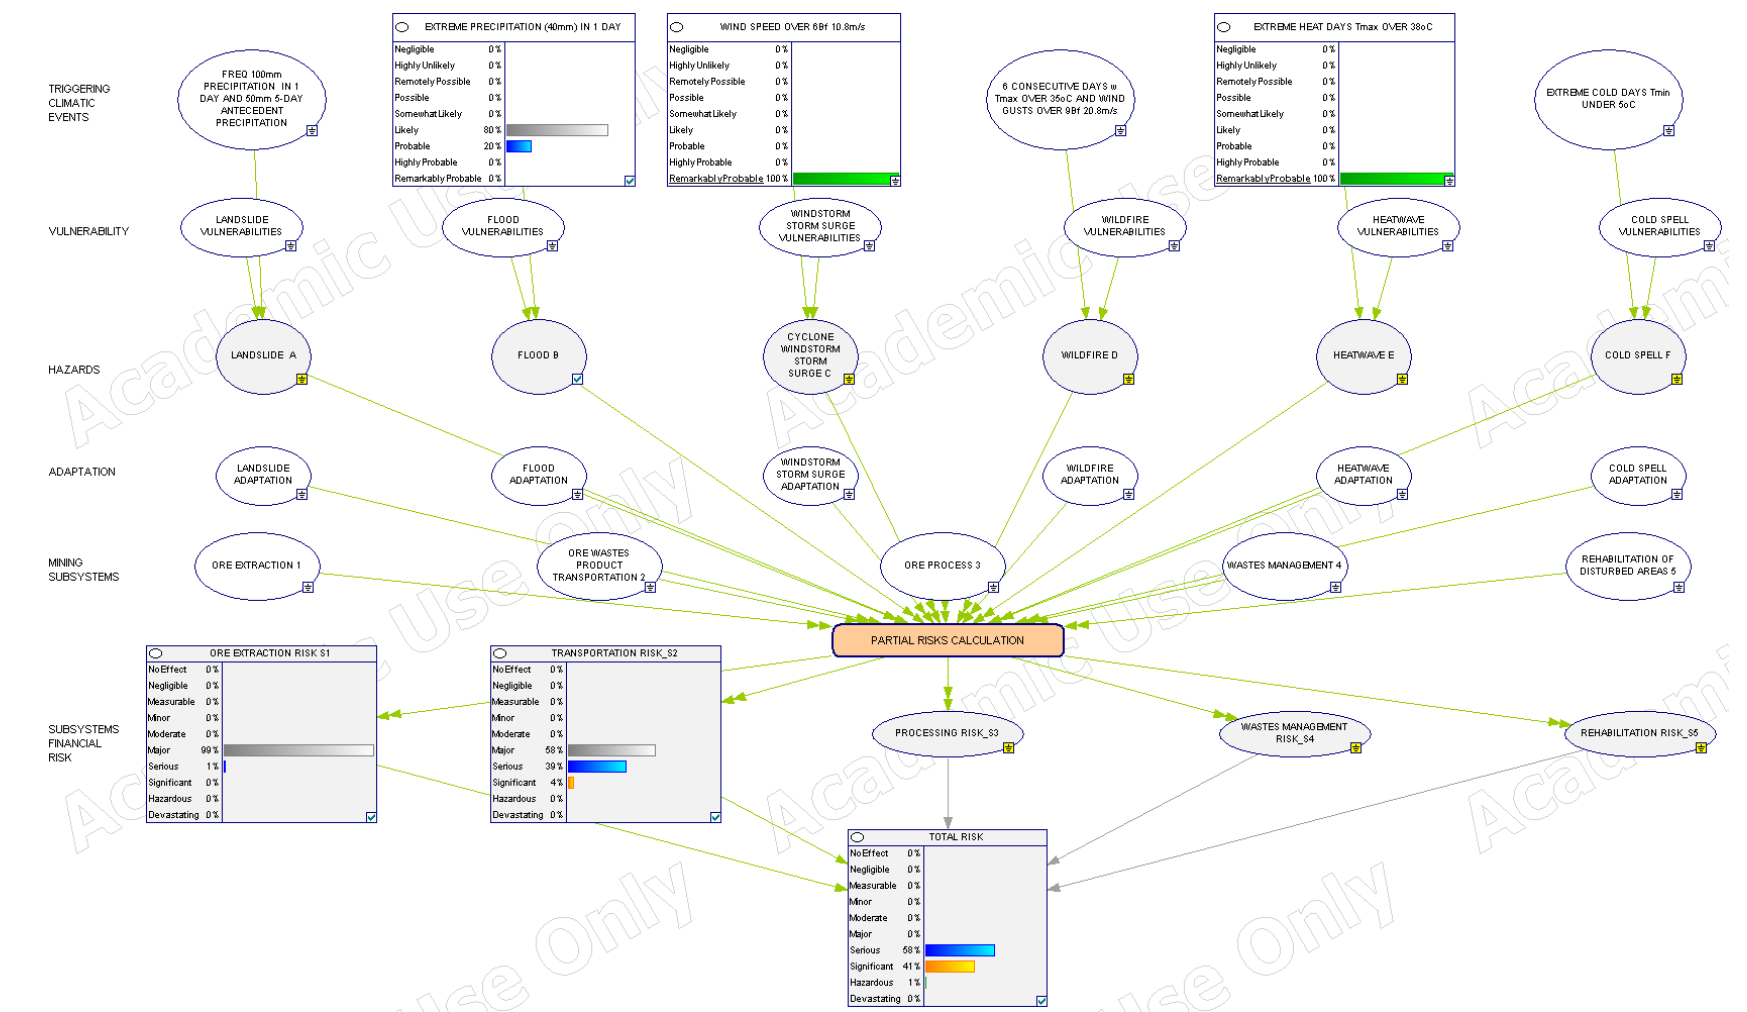
Figure 3. Discrete Bayesian Model for CLIRMI mine main part.